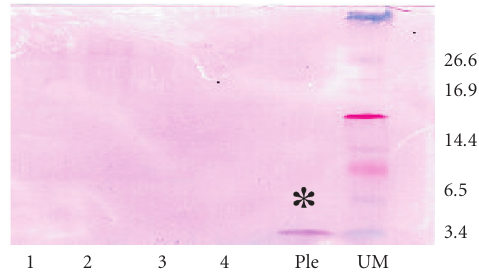
Figure 7. SDS polyacrylamide gel showing synthetic pleurocidin (Ple) band at appx 3000 kd. Dahms [13]). In continuous fermentation systems, cell